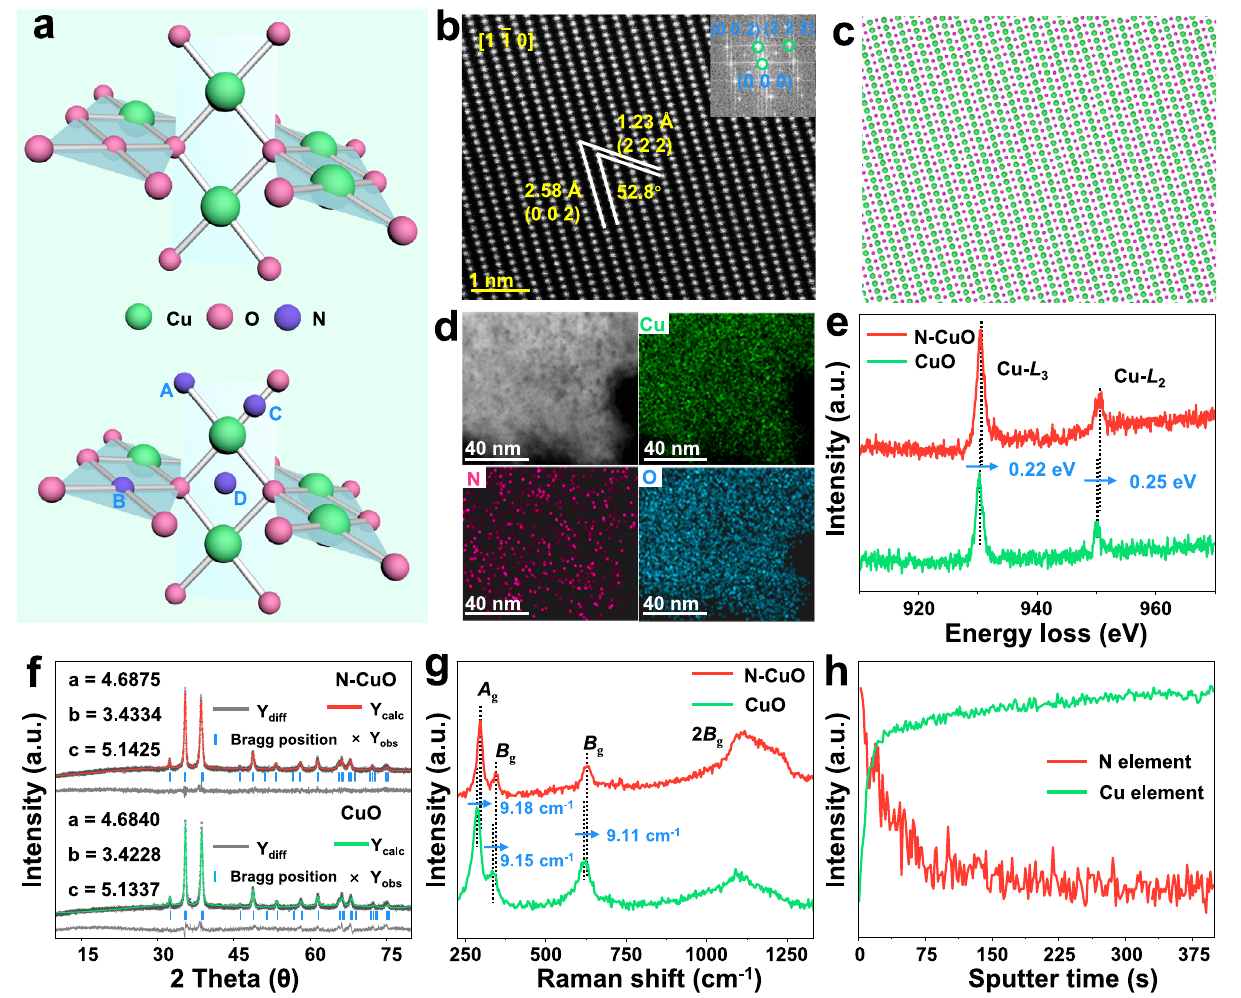
Fig. 2 | Structural characterization of N – CuO. a Schematic presentation of CuO structure (Top: CuO, Bottom: Nitrogen substitution site.). b HAADF-TEM image of N – CuO. Inset is the corresponding FFT pattern. The corresponding atomic model